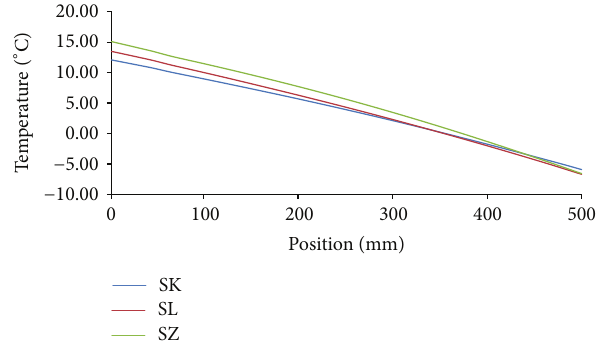
Figure 7: Sorption and desorption isotherms.